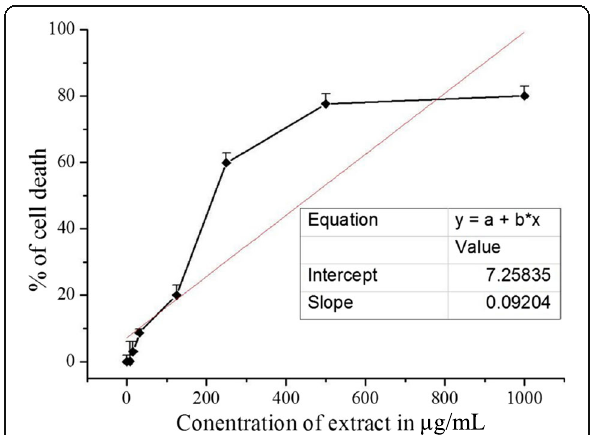
Fig. 3 Concentration dependent effect of C. crepidioides extract on INS-1 cell line. Results are expressed as % of cell reduction (= % of cell death). Values were represented as mean ± SD ( n = 4). Toxicity results for INS-1 cell line incubated with different concentrations of extract